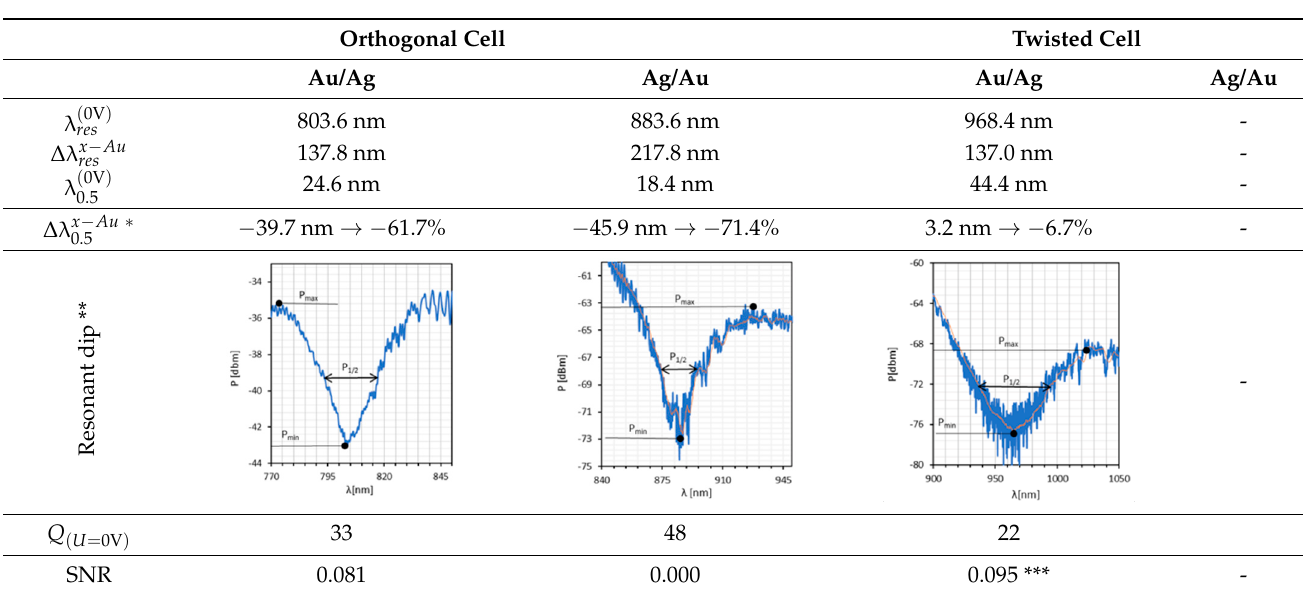
* Reduction in peak width relative to the Au layer; ** The solid lines are the fitting curves, *** Ap ‐ proximated parameter. Table 3. Comparison of resonant dips of a parallel cell. Table 3. Comparison of resonant dips of a parallel cell. Table 3. Comparison of resonant dips of a parallel cell. Parallel Cell Au/Ag